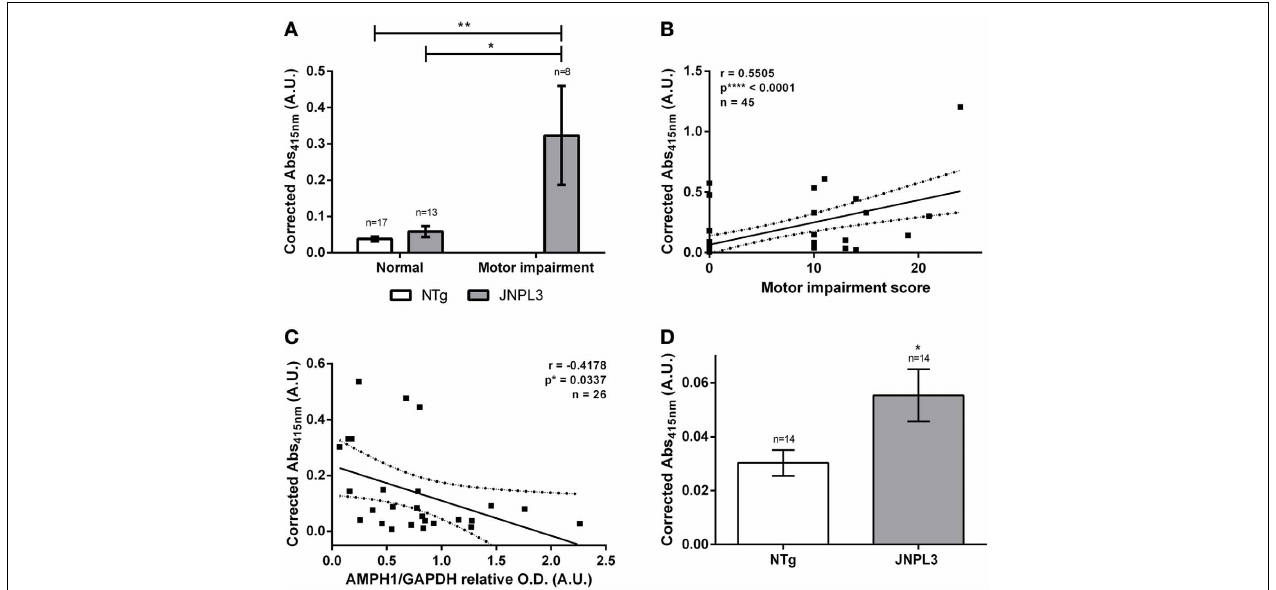
FIGURE 3 | Auto-AMPH1 antibodies are biomarkers of tau-mediated neurodegeneration in the JNPL3 tauopathy mouse model. (A) ELISA shows increased levels of auto-AMPH1 antibodies in JNPL3 mice with motor impairment when compared to normal JNPL3 mice and NTg littermates. Bar graph shows the mean ± standard error of the mean (s.e.m.) for each group. Means were compared by two-way ANOVA; p ∗∗ = 0 . 0032, p ∗ = 0 . 0102. (B,C) The amount of auto-AMPH1 antibodies in serum positively correlates with motor